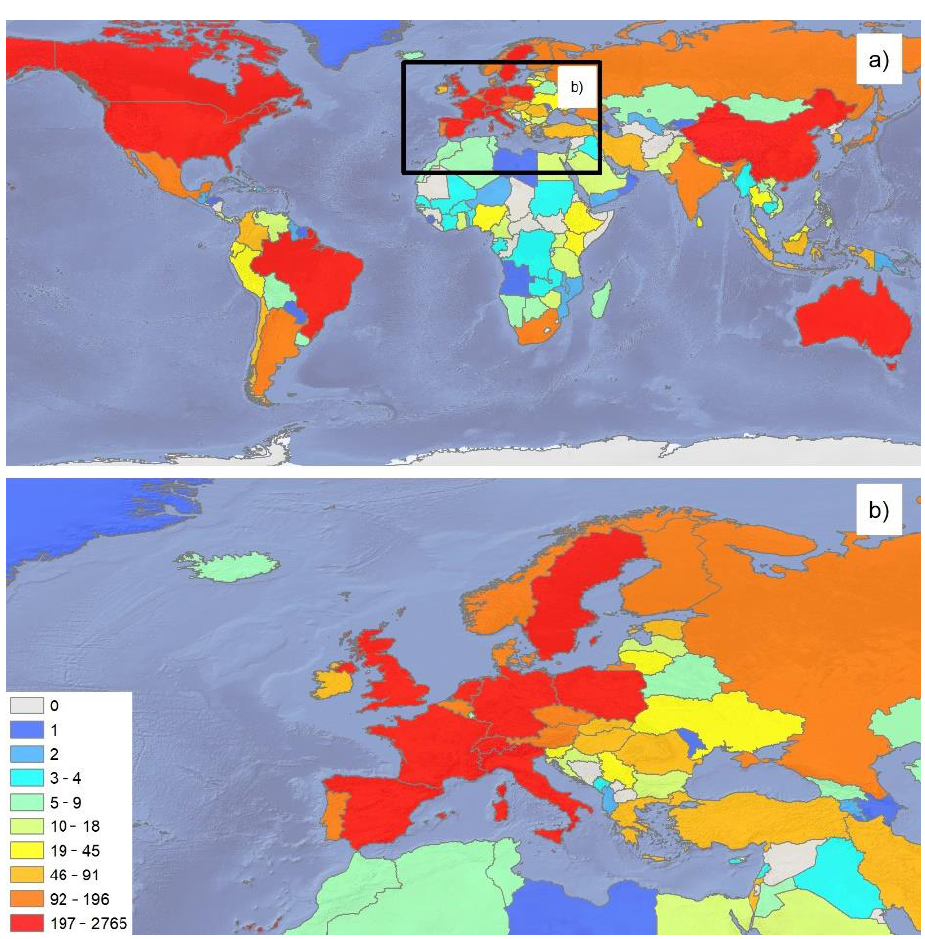
Figure 3. Spatial distribution of the countries of article authorship ( a ) in the World and ( b ) in Europe. World background taken from @ naturalearthdata.com. The graph was extracted using QGIS software.